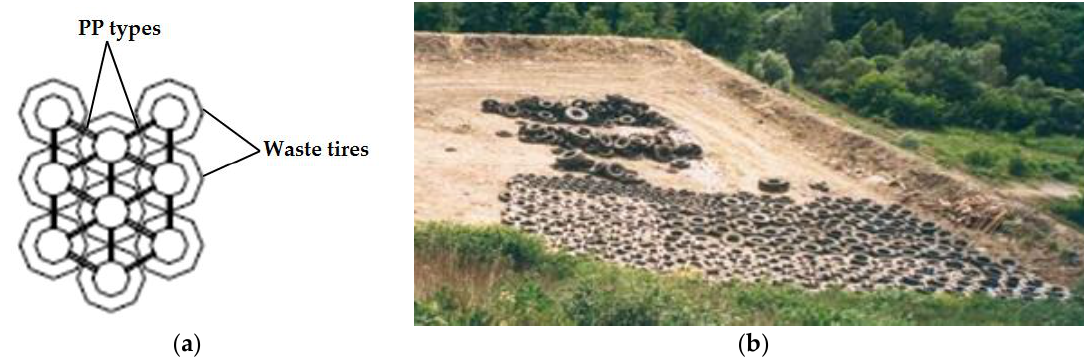
Figure 3. ( a ) Scheme of tire junction with PP- polypropylene tape, and ( b ) tire mattresses built in the landfill slope; landfill